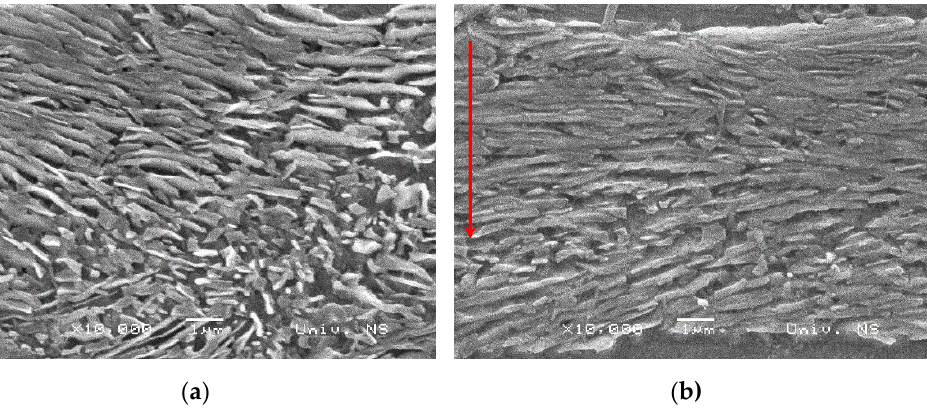
Figure 17. Microstructure of specimen in Zone I ( a ) and Zone IV ( b ) for strain level ε z3 = 1.10 (red arrow—direction of upsetting).